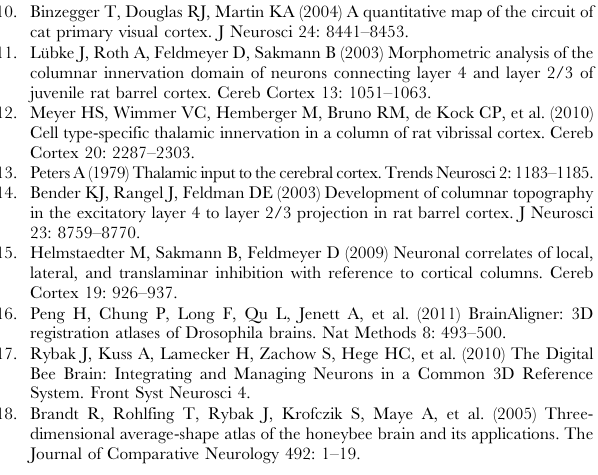
Figure S2 Automated segmentation of barrel contours from 40 6 image (see also Figures 2–3). Abbreviations: TH – top hat; VR – Voronoi region; LM – landmark; CC – connected component; r 45/85 – quality of circles with radius of 45/85 pixels. (TIF) Figure S3 3D reconstruction of anatomical landmarks from 2D contours (see also Figures 4A–B). Abbreviations: S01 – vibratome section 01; d/d (x,y) – value of distance transform (at position x,y); a (…, …) – angle between two vectors; v – vessel orientation vector; n pia – normal of pia surface triangle; r – distance of vertex to vertical axis/BC axis; d BC – distance from BC to pia surface triangle. (TIF) Text S1 Detailed description of the image processing and 3D reconstruction pipeline. The pipeline shown